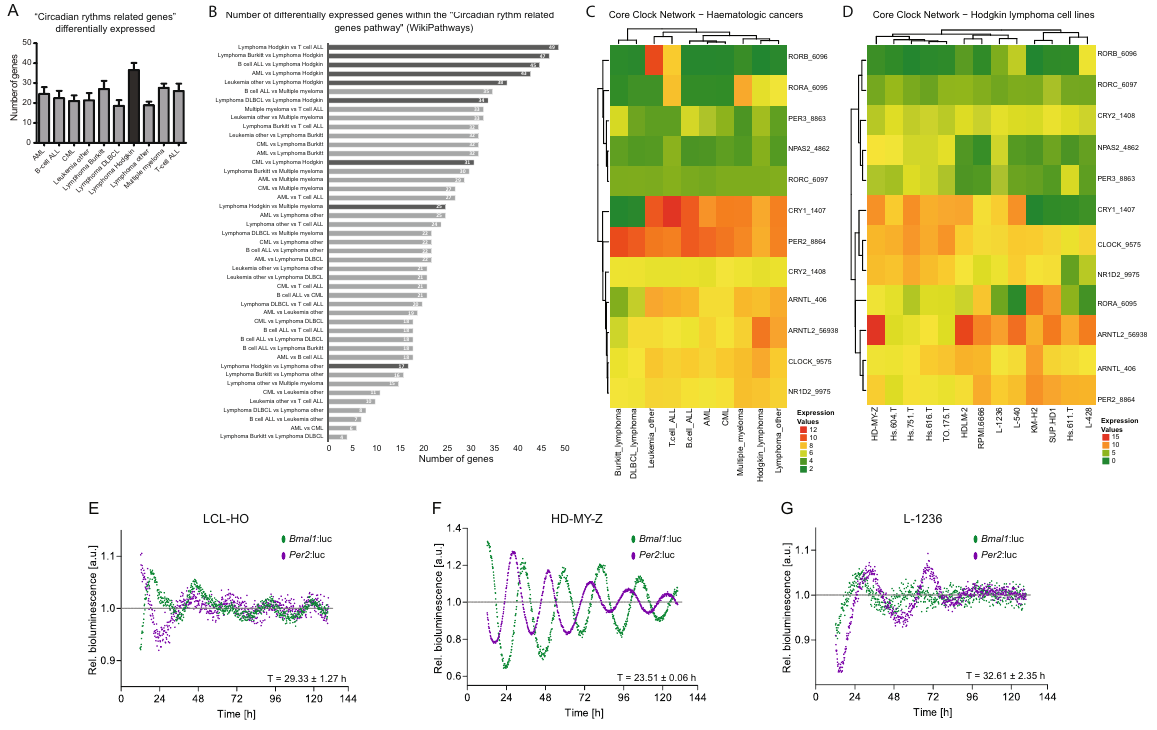
Figure 2. Cancer cell line encyclopedia (CCLE) analysis revealed a circadian signature in Hodgkin lymphoma cell lines. ( A ) Represented is the number of genes, belonging to the “Circadian rhythms related genes” (WikiPathway), differentially expressed in the several haematopoietic and lymphoid tissue cancer cell lines present in the database. ( B ) Individual comparisons between the groups of cell lines regarding the number of differentially expressed genes of the pathway referred in A. ( C , D ) Heatmaps for relative expression levels of CCN genes in haematopoietic cancers and Hodgkin lymphoma cell lines, respectively. ( E , G ) LCL-HO, HD- MY-Z and L-1236 have differential circadian phenotypes. Shown are bioluminescence readouts for the promoter activity of Bmal1 (green) and Per2 (purple) over the course of 144 hours in LCL-HO (T = 29.33 ± 1.27 h; phase Bmal1 = 18.67 ± 0.3 h) ( E ) and the HL cell lines HD-MY-Z (T = 23.51 ± 0.06 h; phase Bmal1 = 11.64 ± 0.26 h) ( F ) and L-1236 (T = 32.61 ± 2.35 h; phase Bmal1 = 20.15 ± 0.3 h) ( G ). Periods and phases were calculated with ChronoStar software (n = 3, mean ±